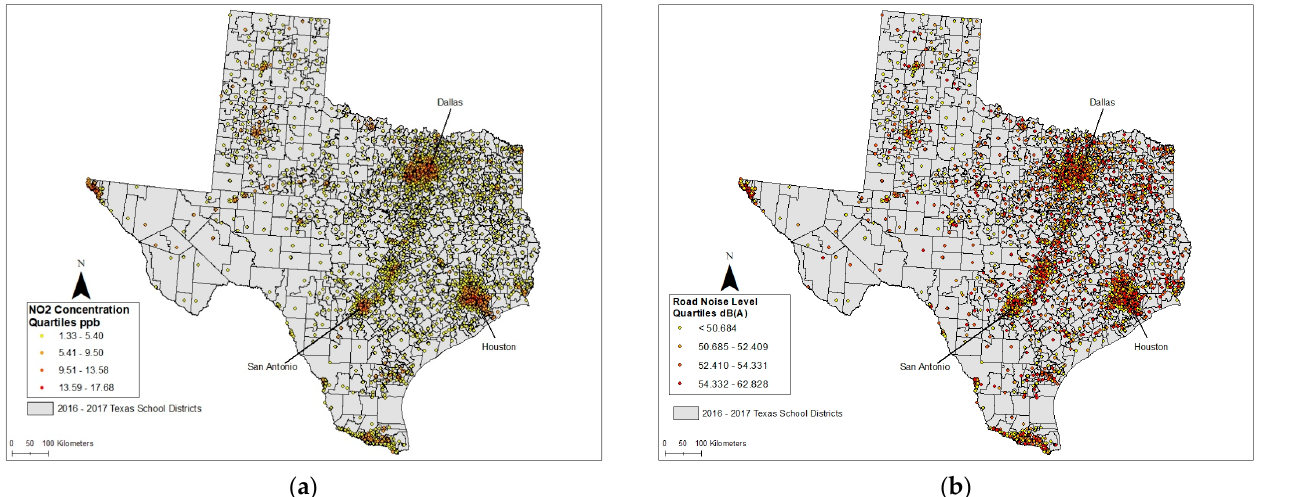
Figure 1. ( a ) School-level distribution of average NO 2 concentration in parts per billion (ppb): 2011–2015; ( b ) school-level distribution of road noise level in A-weighted decibels (dB(A)): 2016.